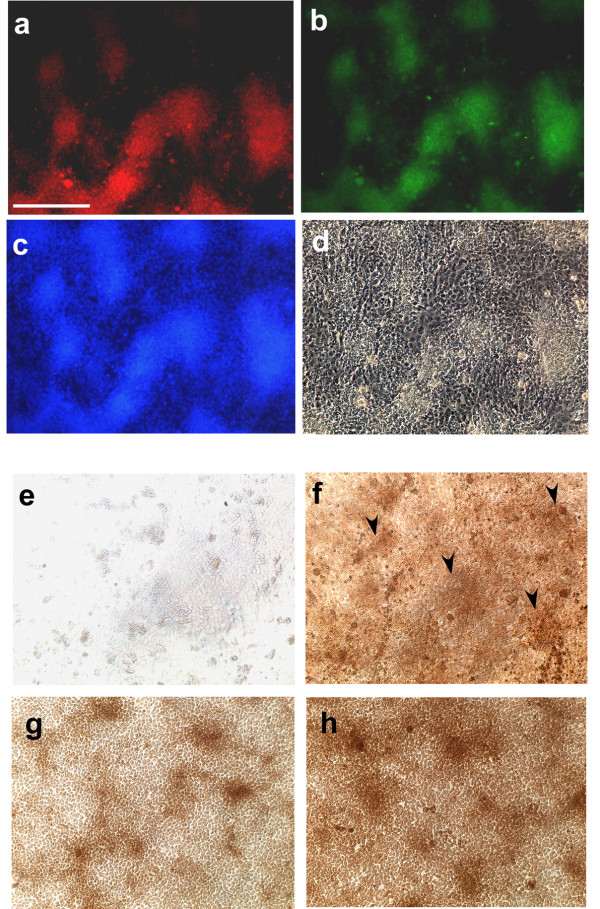
CG-1A is an early endogenous marker for limb precartilage condensations in vitro. (a-d) A microscopic field in a 2-day leg micromass culture showing (a) indirect immunolocalization of CG-1A, (b) staining with FITC-conjugated peanut agglutinin (PNA); and (c) DAPI. The same field was photographed under (d) phase-contrast microscopy. (e-f) 9-hour fixed cultures incubated with (e) HRP-conjugated PNA fail to show staining but when immunostained for (f) CG-1A show patchy "proto-condensations" at 9 h of incubation (black arrowheads). (g-h) 18-hour fixed cultures incubated with (g) HRP-conjugated PNA or immunostained for (h) CG-1A show fully formed condensations of similar spatial patterns. Images (a-h) are at same level of magnification; scale bar in (a) represents 0.2 mm.